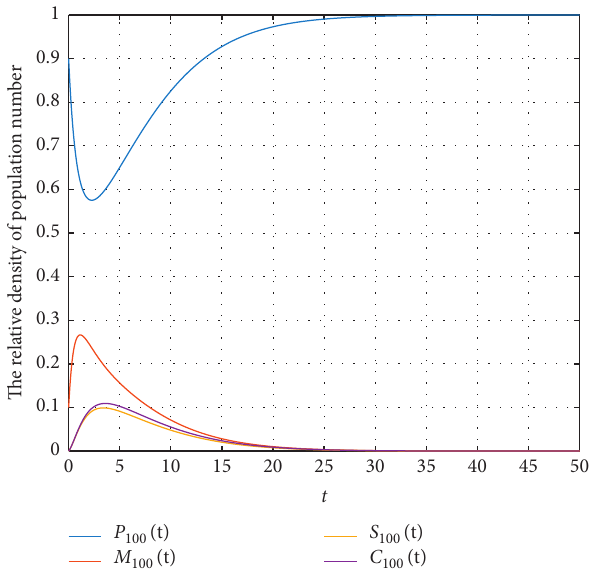
and ρ on R . 0 1 2